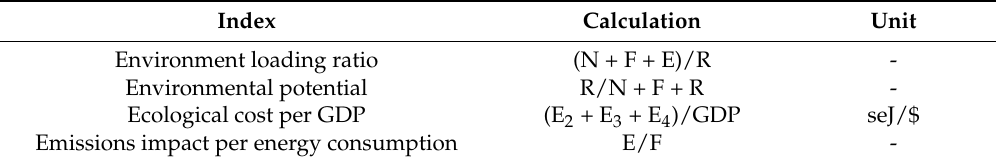
Table 1. Emergy-based indicators considered in the